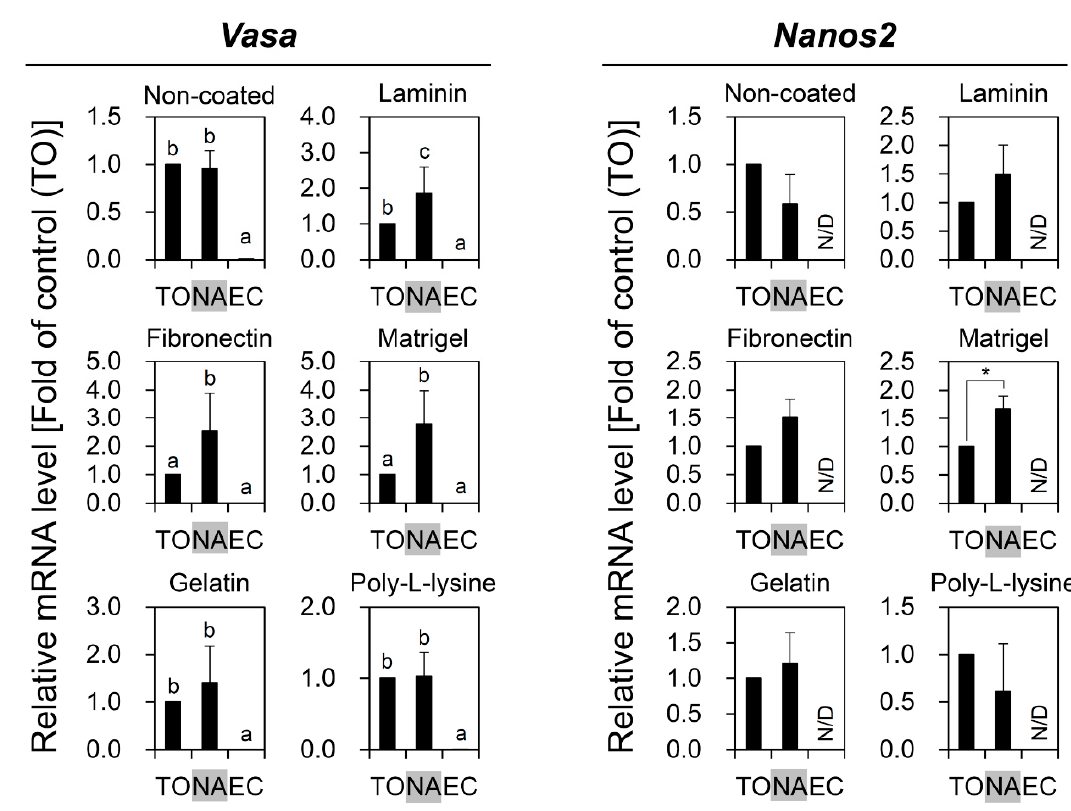
Figure 4. Comparison of Vasa and Nanos2 expression between crude TO and NA cells derived from DP of TO. TO from five adult female fish was subjected to DP on plates coated with gelatin, fibronectin, laminin, Matrigel, or poly- l -lysine. NA cells were then collected from each plate. TO, NA, and Japanese medaka embryonic cells (EC), which were used as a negative control, were subjected to qRT-PCR for comparison of Vasa and Nanos2 expression levels. Significant increases in Vasa expression compared to TO were observed in NA cells from laminin, fibronectin, or Matrigel-coated plates. Only NA cells from Matrigel-coated plates showed significantly higher Nanos2 expression than TO. The values are expressed as mean ± SD. a-c Di ff erent letters and asterisk (*) indicate significant di ff erences; p < 0.05. N / D, not